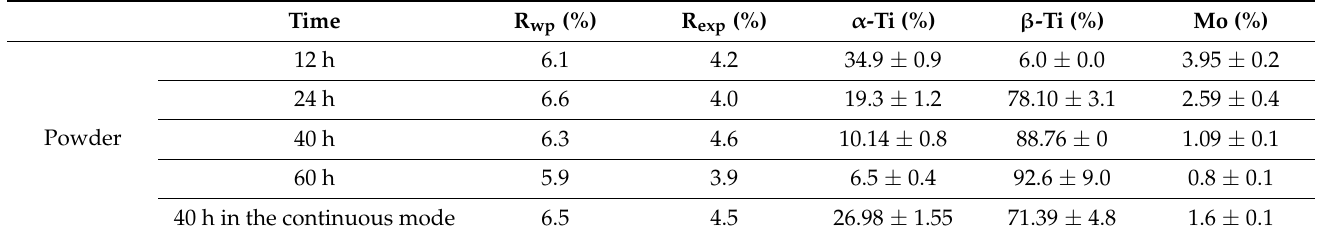
Table 1. Quality parameters of Rietveld refinement and the α , β , Mo phases.